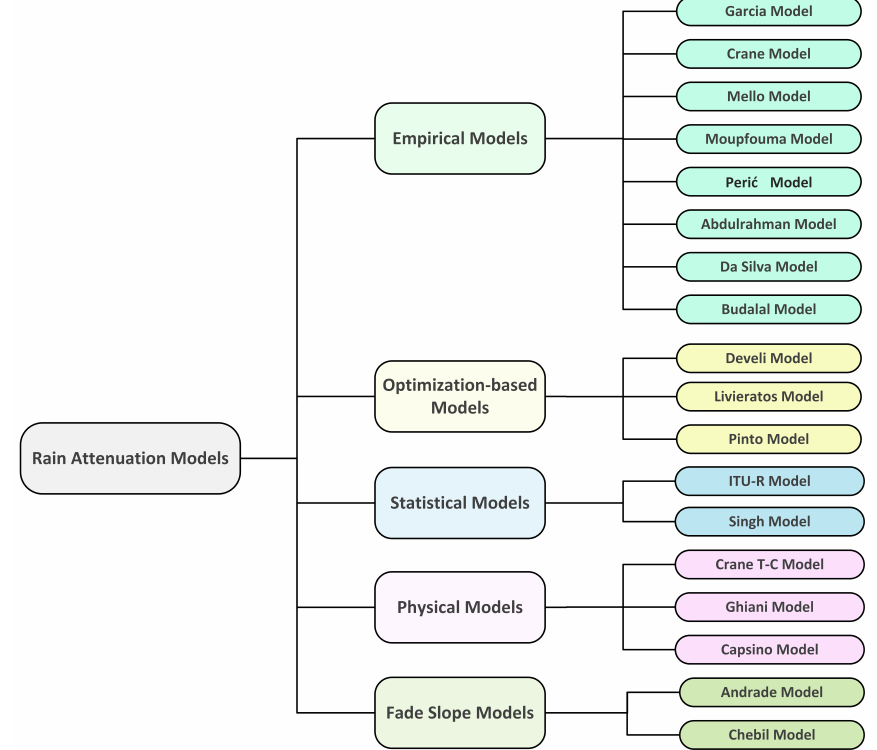
Figure 1. Taxonomy of terrestrial rain attenuation